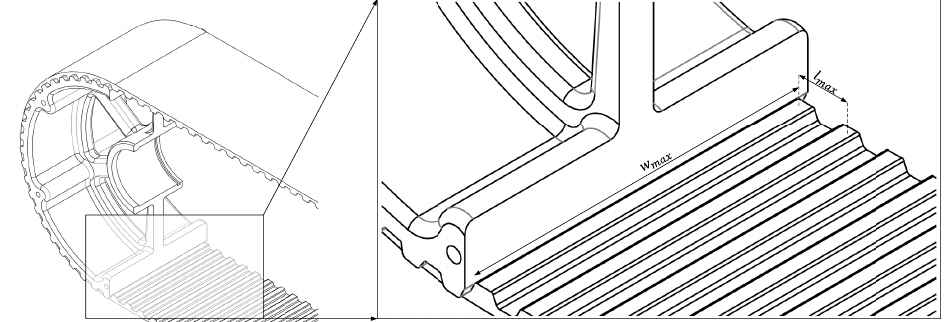
Figure 4. CAD model of rubber tracking belt and timing